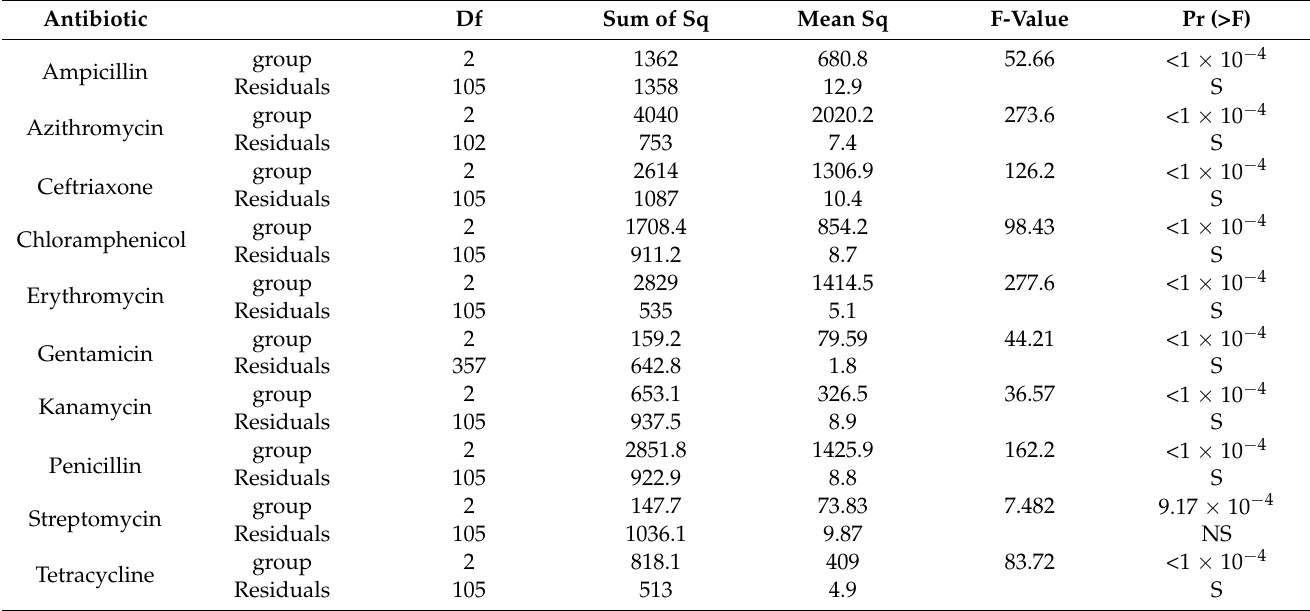
Table 1. One-way ANOVA tests for zone of inhibition (ZoI) diameters (mm) of each antibiotic comparing 3 groups of bacteria (commensal, reference, pathogenic).